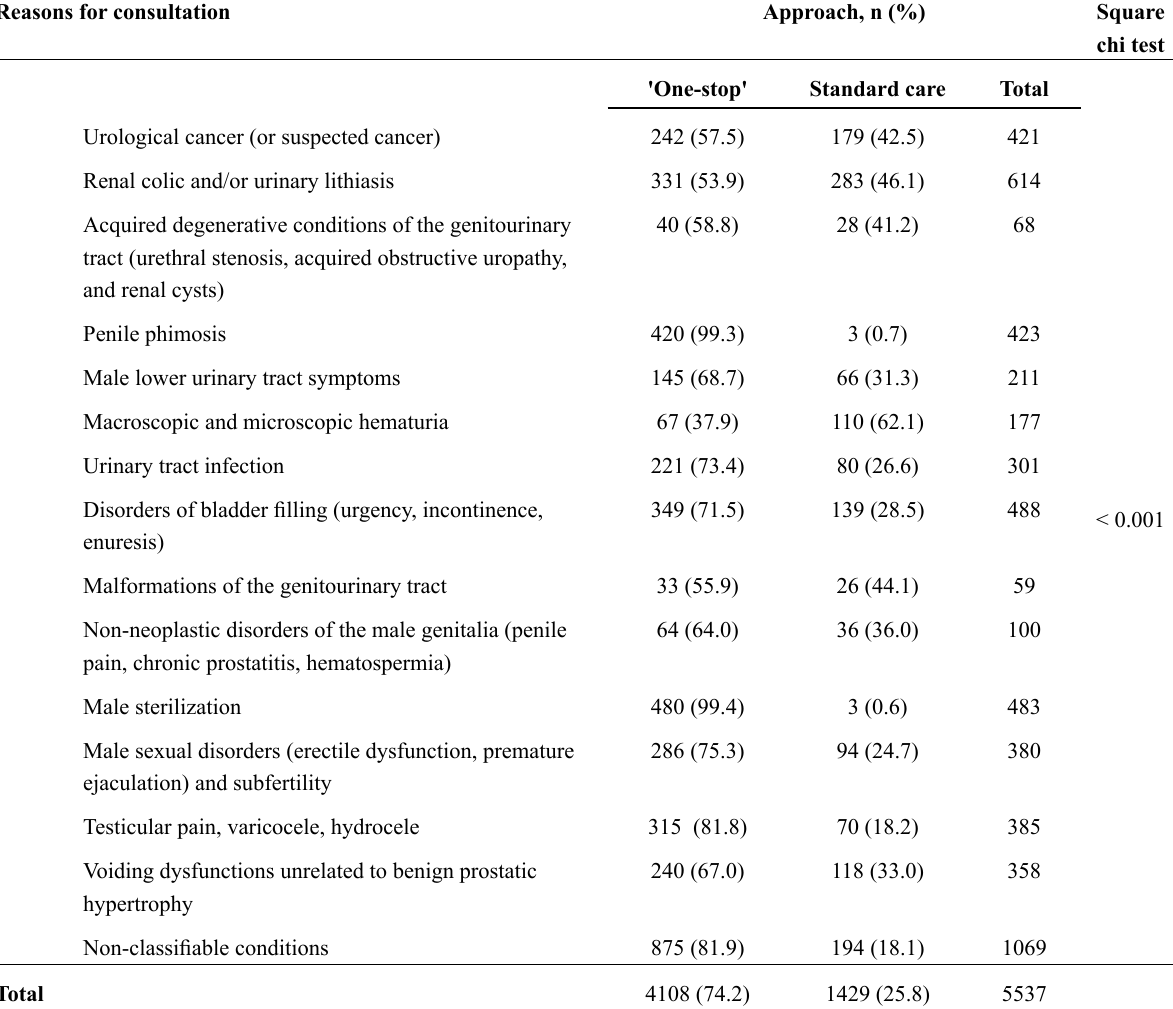
Table 3 - Relationship between clinical syndrome and type of approach ('one-stop' or standard care). In parentheses, percent. Reasons for